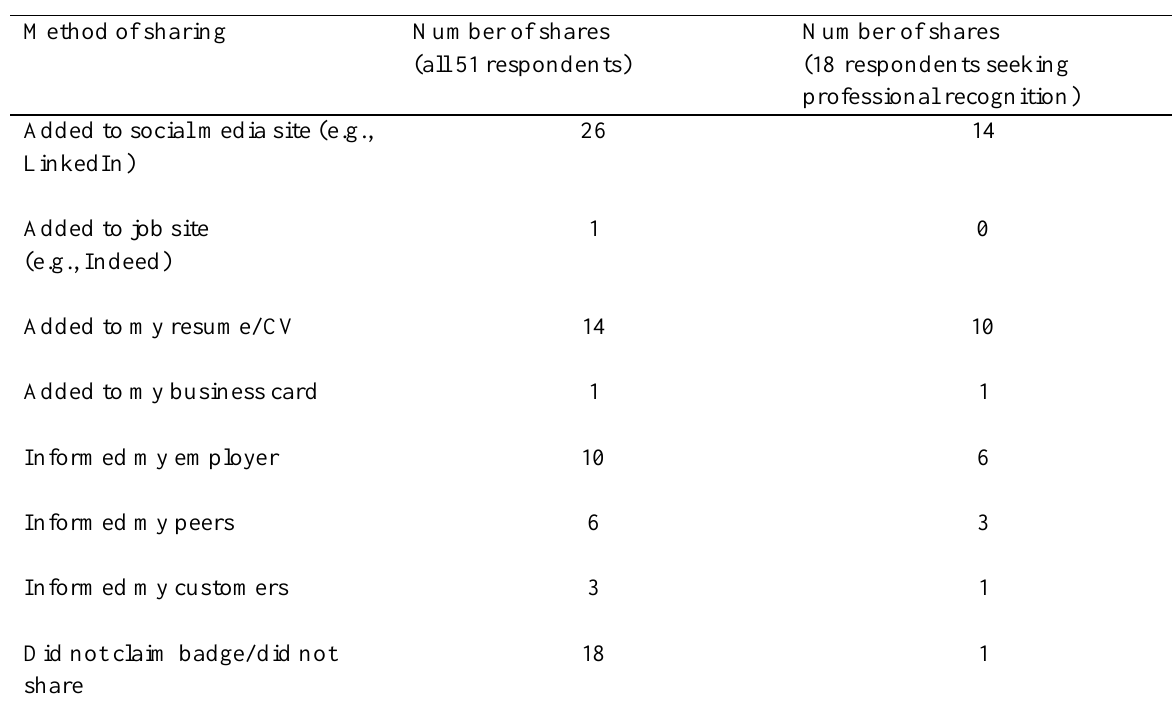
Table 2 How Participants Shared Their Earned Credential Method of sharing Number of